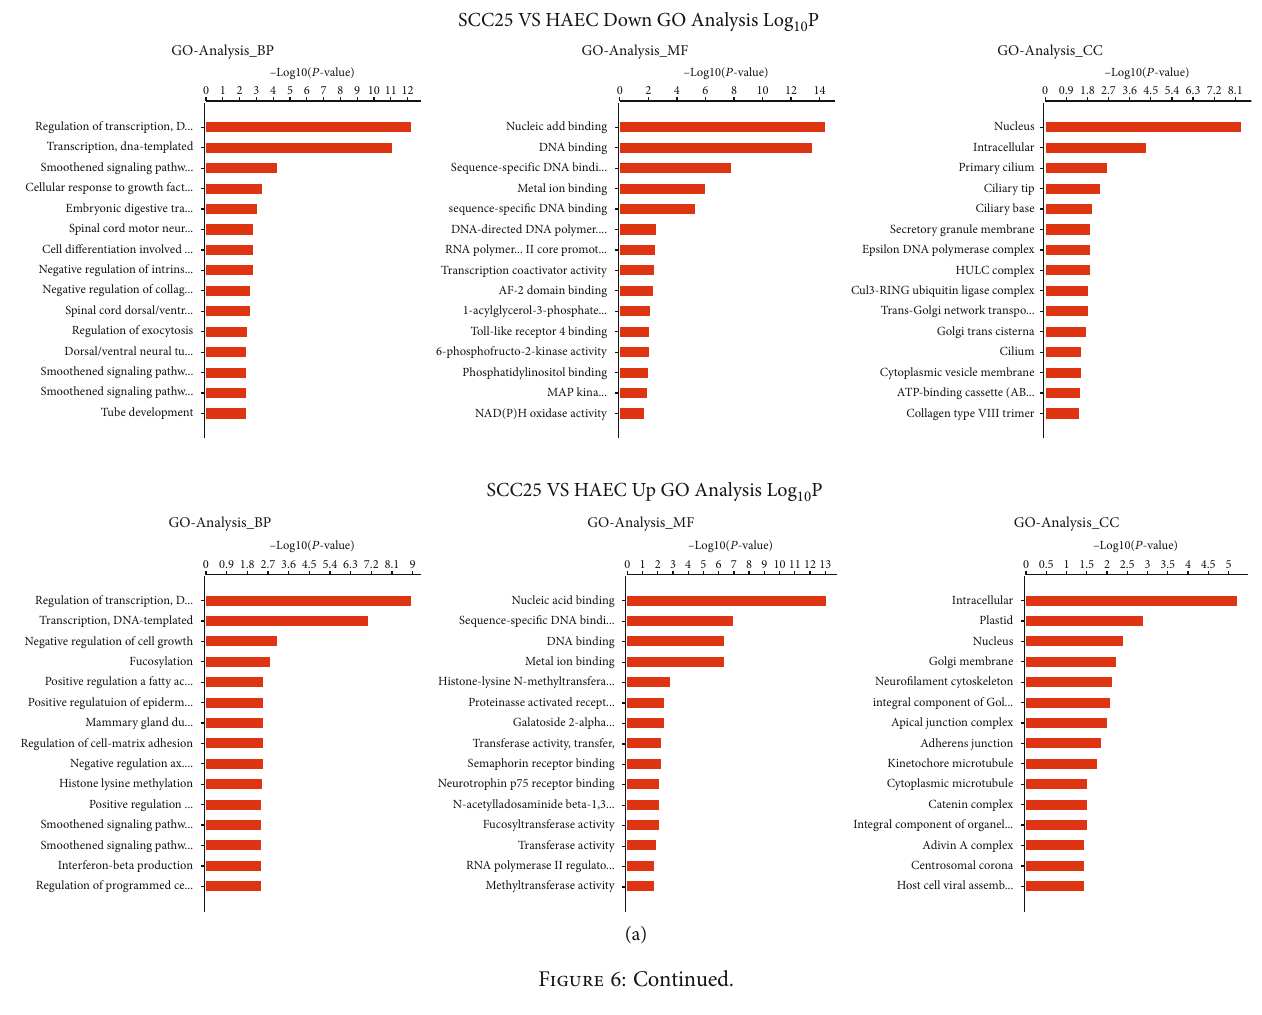
Catenin complex Integral component of